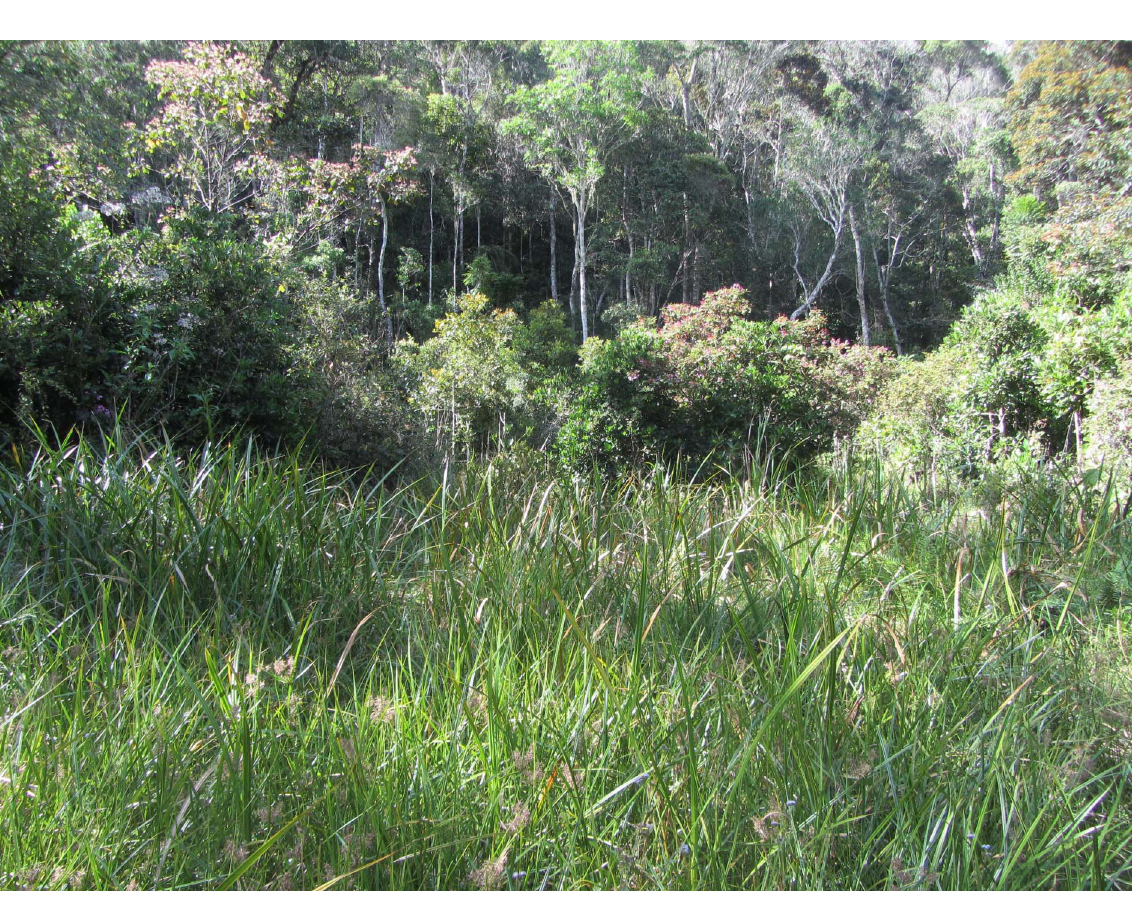
Fig. 5. Type locality [MAD14-78] for Bidessus anjozorobe sp. nov. in Anjozorobe forest in Anjozorobe- Angavo protected area on the Central Highlands. A glade in the rainforest with marsh vegetation. Multiple individuals of Bidessus anjozorobe sp. nov. were found by tramping in the vegetation at the edges of the